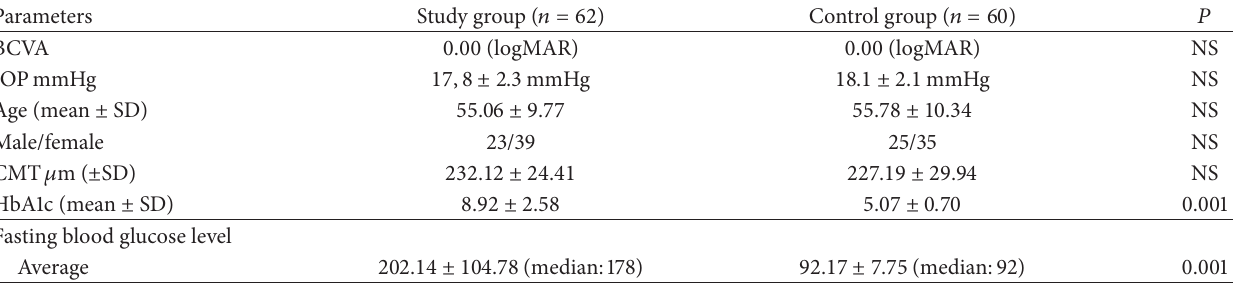
Table 1: Demographic characteristics, values for central macular thickness (CMT), and biochemical analysis in patients with type 2 diabetes without clinical retinopathy.